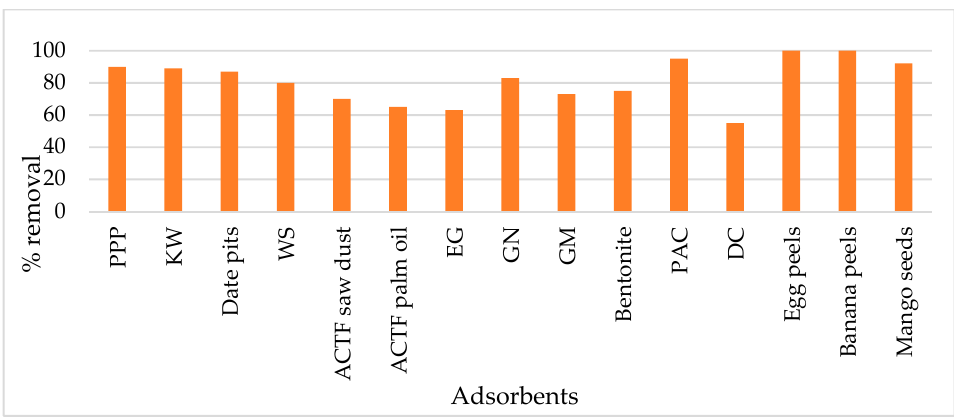
Figure 6. Removal of oil from produced water for the various adsorbents, including PPP (pomegranate peel powder), EG (exfoliated graphite), KW (kiwi), WS (walnut shell), GN (graphene nanoplatelets), GM (graphene magnetite), PAC (powdered activated carbon), and DC (deposit carbon). El-Syed et al. [121] investigated the use of synthesized amorphous carbon thin films that were derived from sawdust wood and utilized them for oil adsorption in a fixed-bed column system. A maximum uptake of 700 mg oil/g adsorbent was obtained at a flow rate of 0.5 mL min − 1 and with a bed height of 5 mm. Takeuchi et al. [122] studied the use of exfoliated graphite (EG), and the result showed that 278 and 66 mg/L of oil was decreased to 1.2 mg/L and undetectable, respectively. Abou et al. [123] investigated